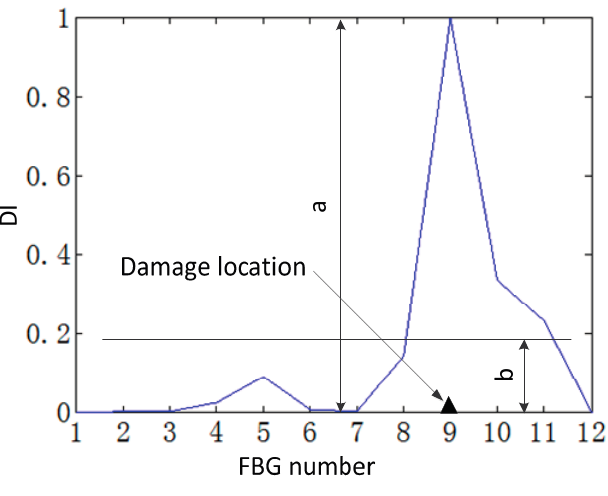
Figure 12. Mean damage detection error.